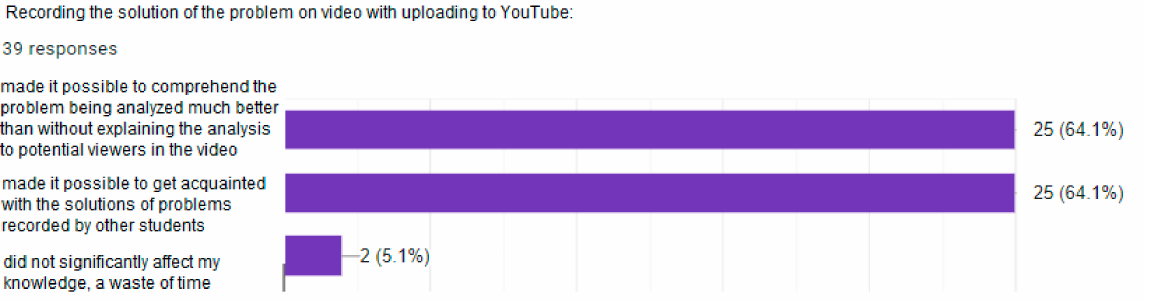
Figure 7. Influence of recording explanations of problem solutions for other students to master the problem